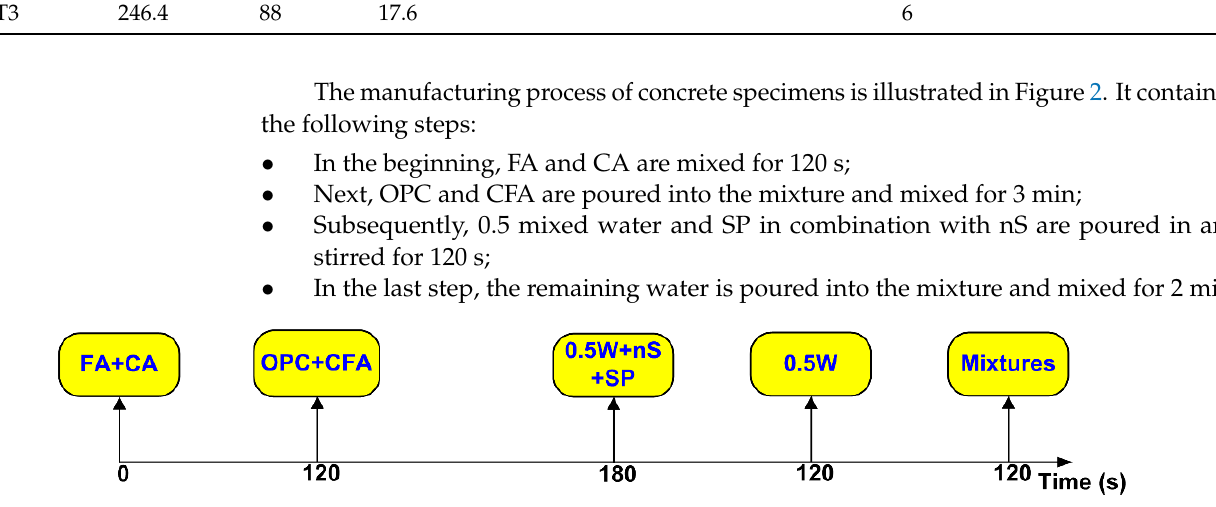
Figure 2. Mixing flowchart of concrete specimens.